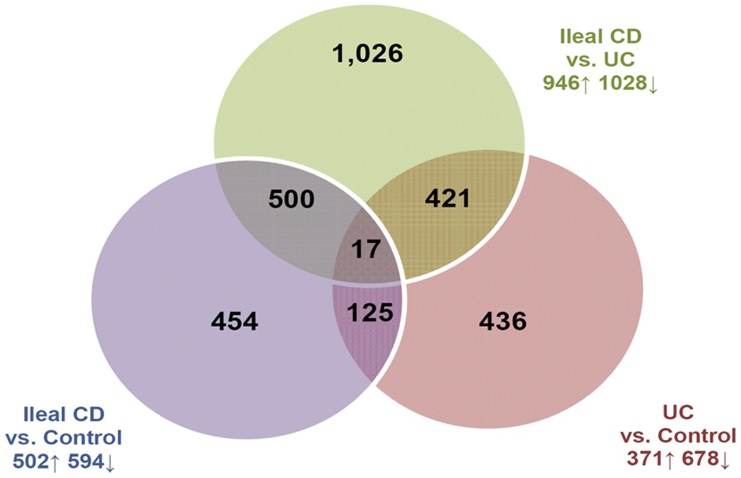
Venn diagram of the union of the gene-probes identified by SAM.Two-class unpaired SAM analyses of ileal CD vs Control samples, UC vs. Control Samples and ileal CD vs. UC samples have been conducted. The number of gene-probes that overlapped between the three separate analyses is shown within the Venn diagram. The total numbers of upregulated and downregulated gene-probes for each individual analysis are shown on the side.